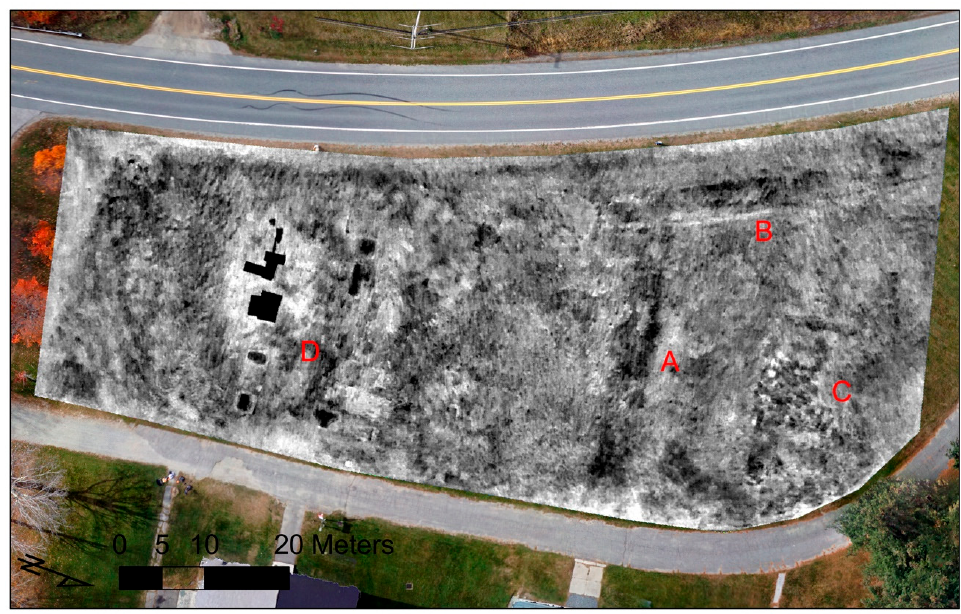
Figure 8. Thermal difference map for 8 p.m. and 11 p.m. 11 May 2017.